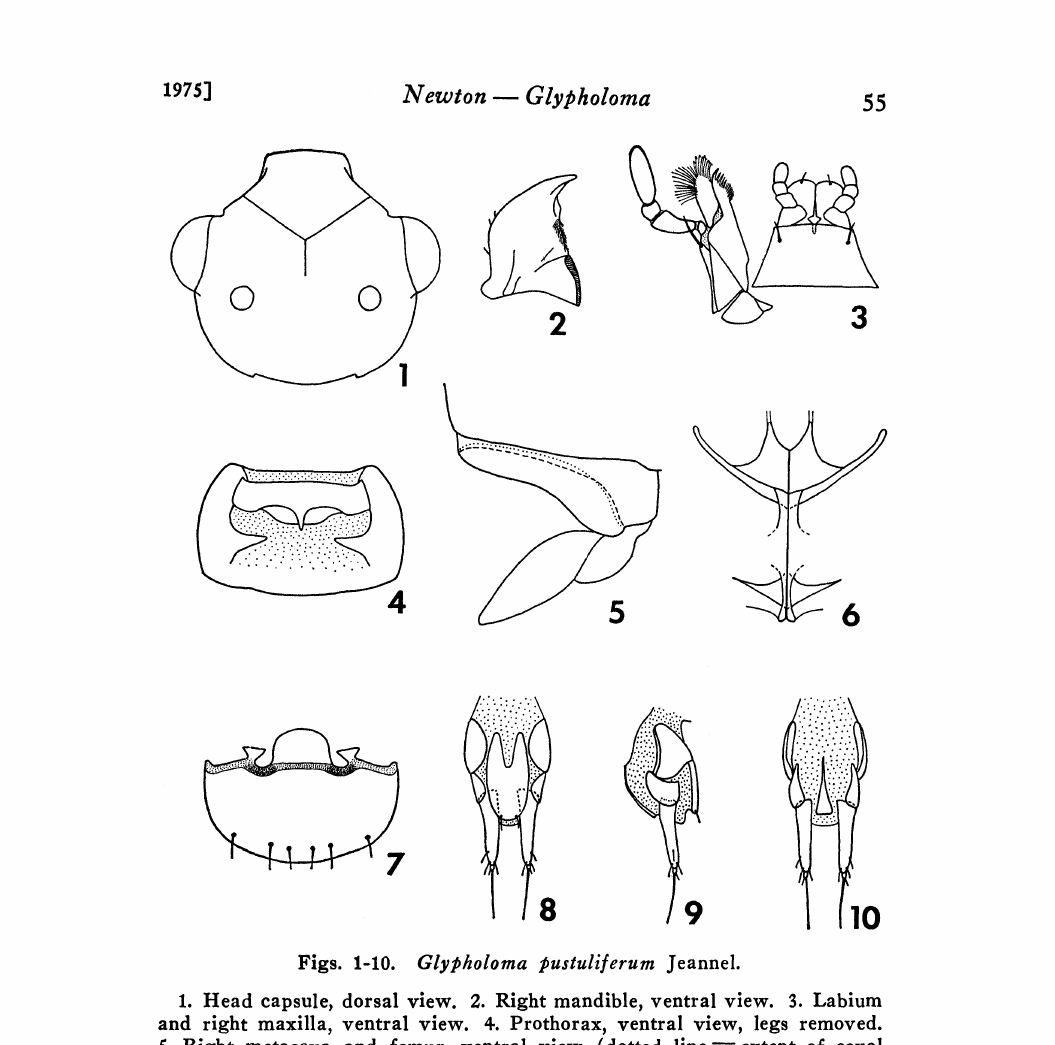
Figs. 1-10. Glypholoma pustuliferum